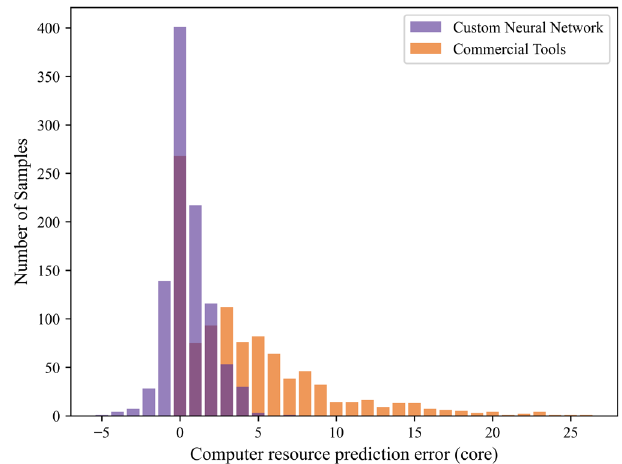
Figure 7. Error distribution in the test dataset.